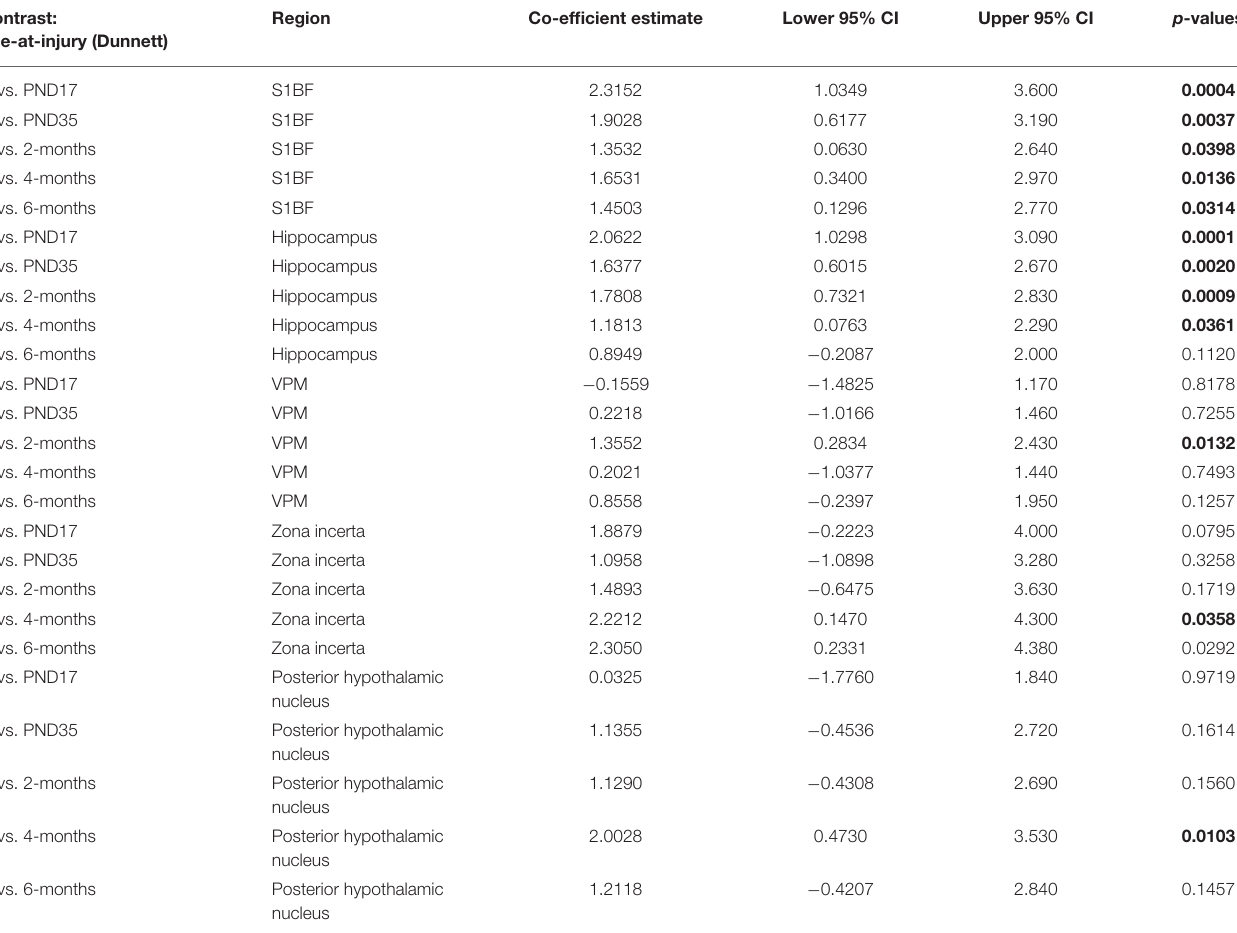
TABLE 6 | TREM2-positive microglia post-hoc contrasts between age-at-injury groups and naïve controls, separated by region, using the Dunnett’s procedure. Contrast: age-at-injury